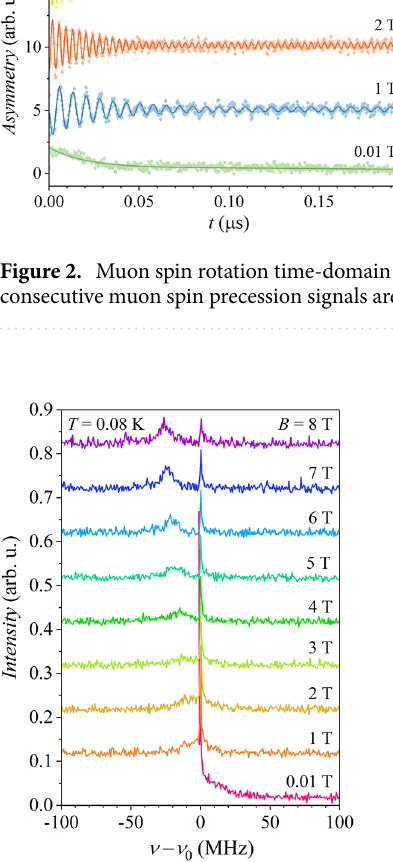
Figure 3. Fourier transforms of the muon spin rotation time-domain data measured at fields up to 8 T. For clarity, consecutive spectra are offset by